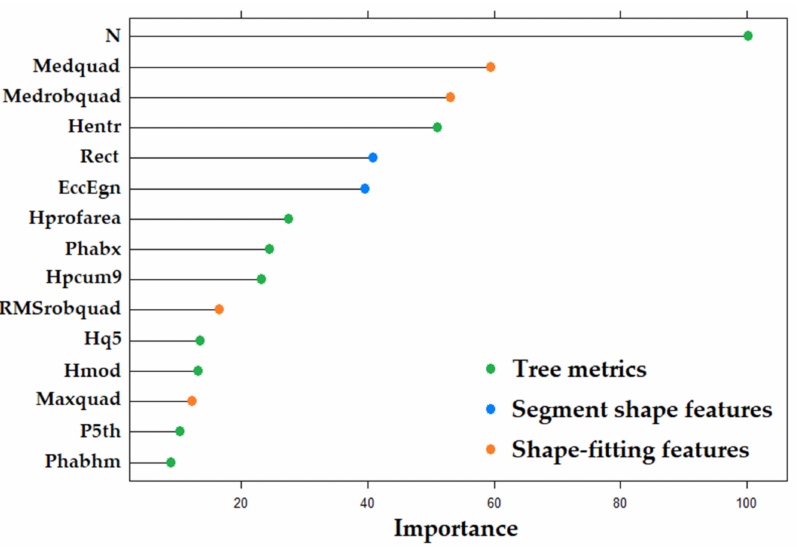
Figure 8. The importance of selected variables expressed by scaled Mean decrease in Gini